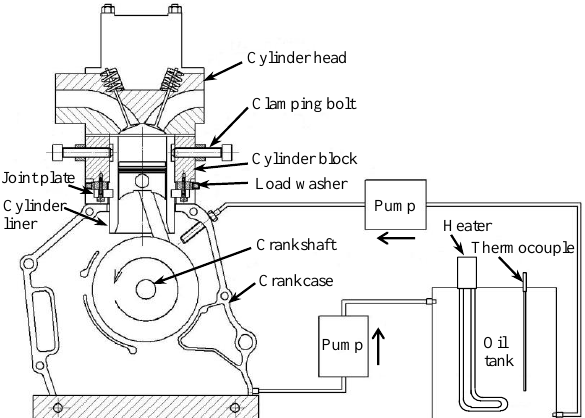
Fig. 1. Measurement apparatus of piston assembly friction